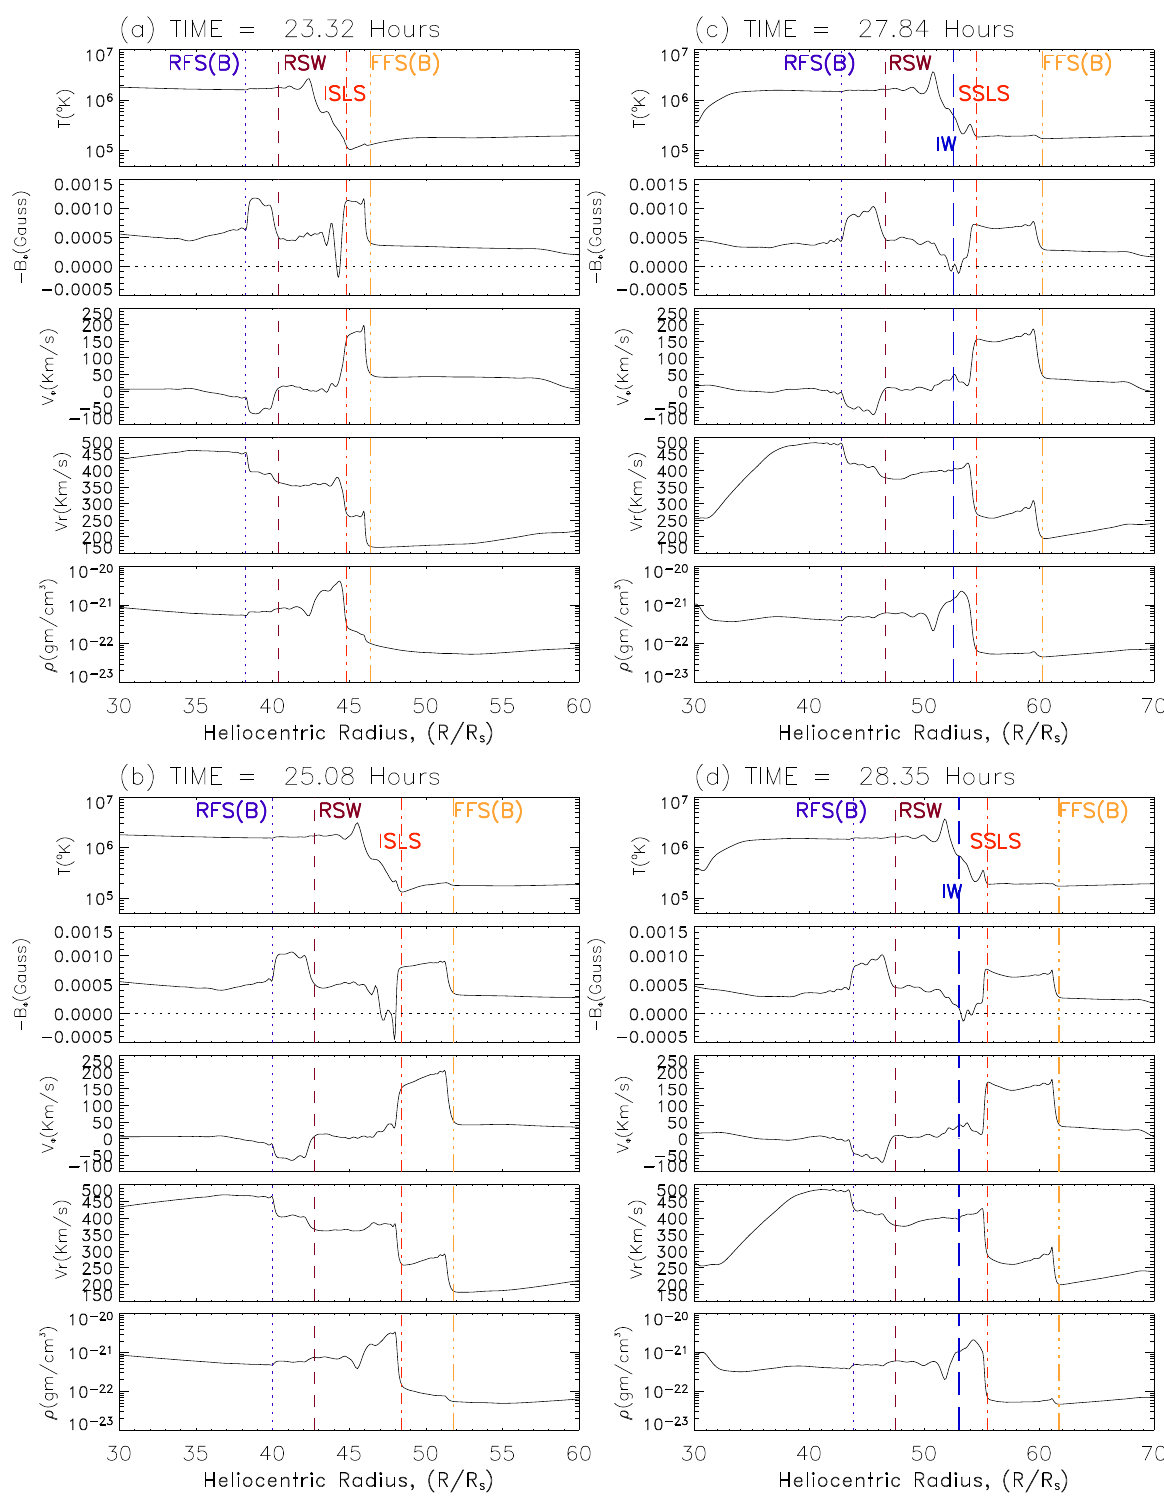
00 v 0 r = 0 . 4 , T 0 = 0 . 4 v = 1 . 6 , T 00 r =5.0. (a) , (b) , (c) and (d) show the solar v r ◦ v r ◦ T ◦ T ◦